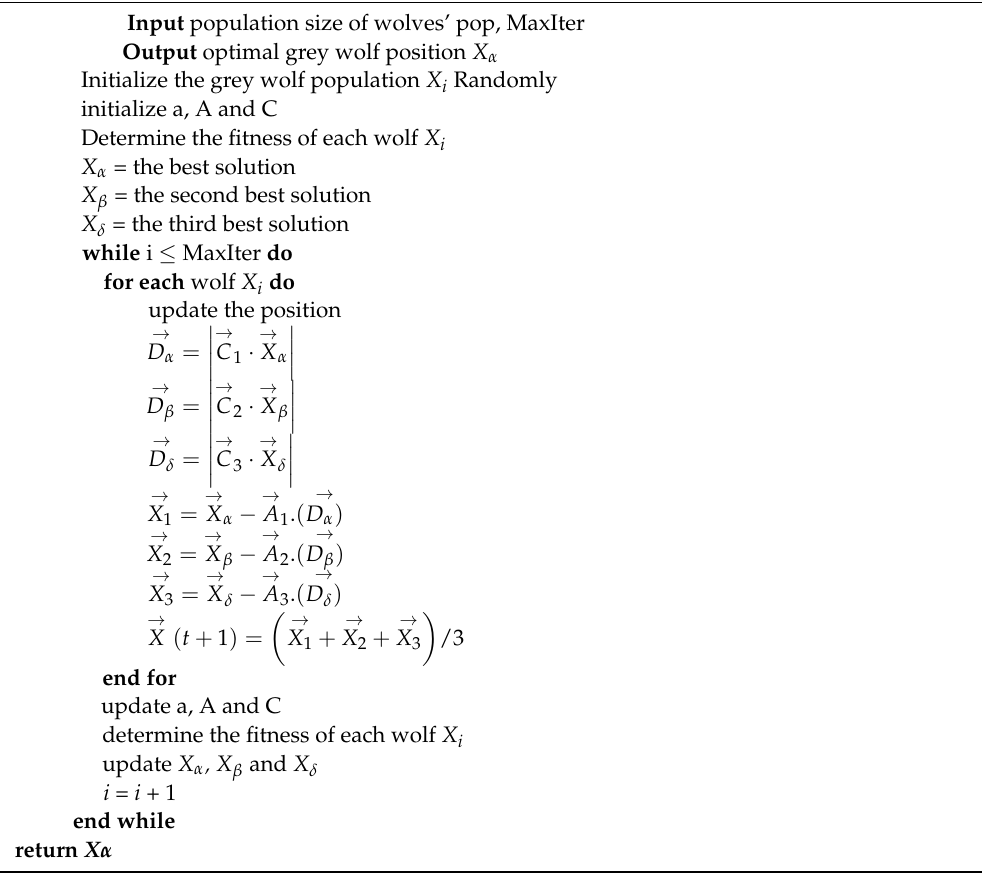
Algorithm 2 Grey Wolf Optimization